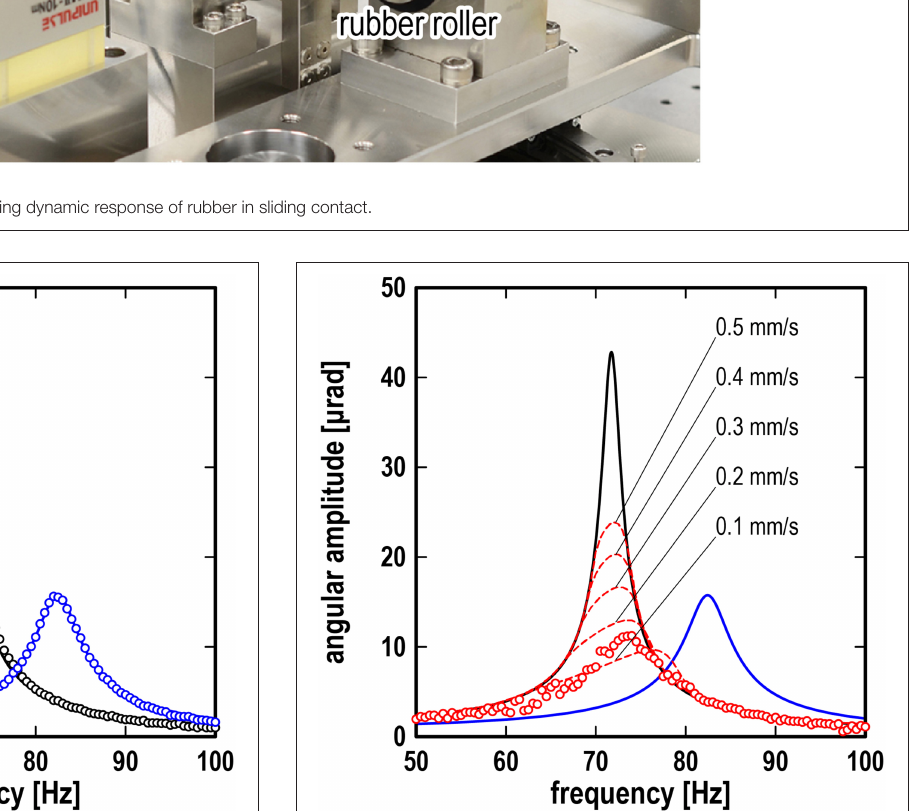
= 20N and V 0.1 to = = 20N and V 20 mm/s. = =